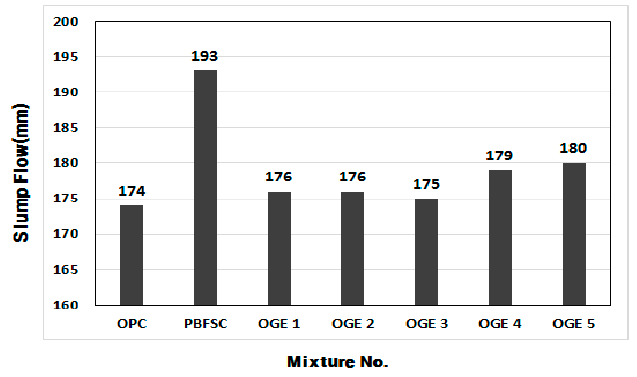
Figure 5. Measured value of flow of OGE (mm) at different ESA burning temperatures.